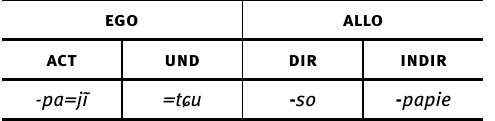
Table 5. Egophoricity and evidentiality in Shigatse Tibetan